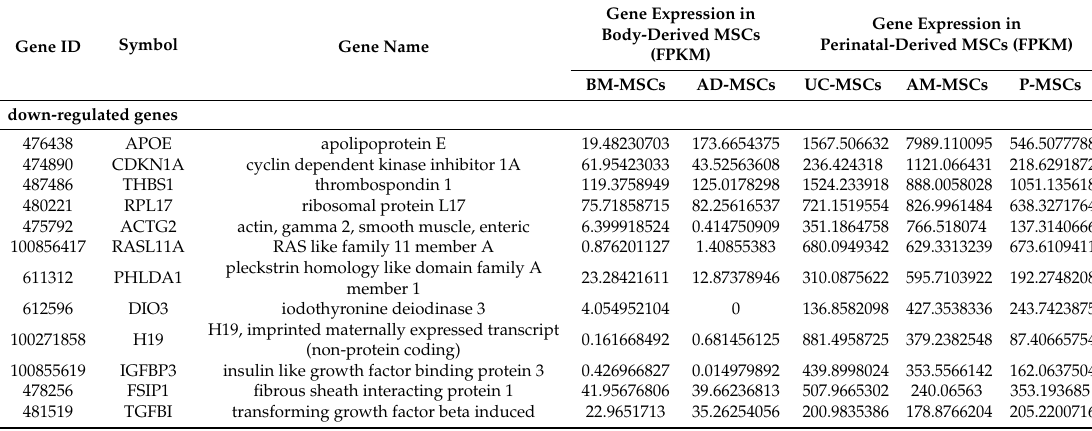
Table 2. Differences in differentially expressed genes (FPKM) between body-derived MSCs and perinatal-derived MSCs.